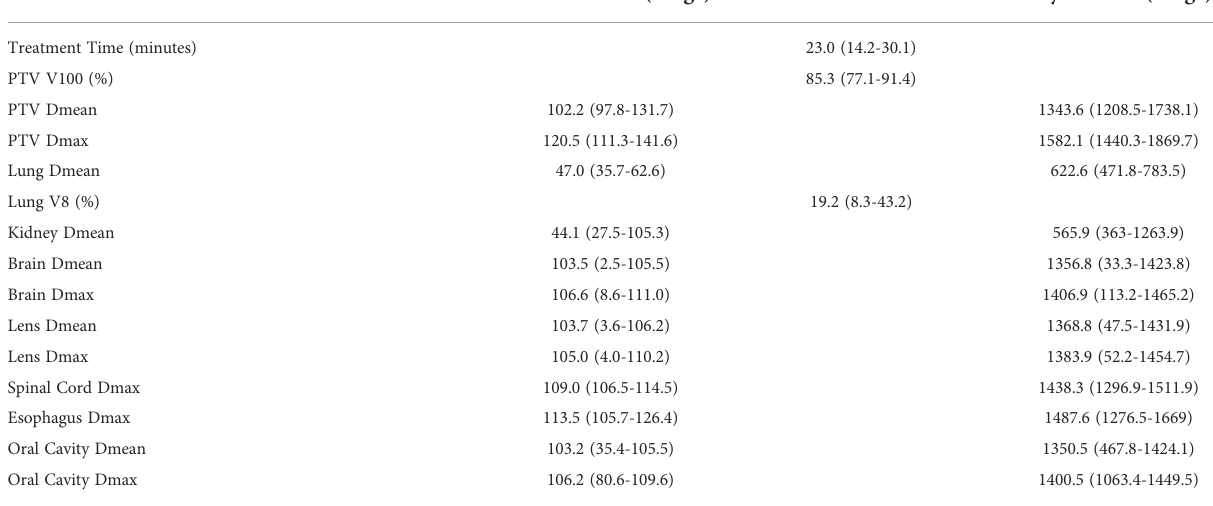
TABLE 2 IMRT TBI Dosimetric parameters.